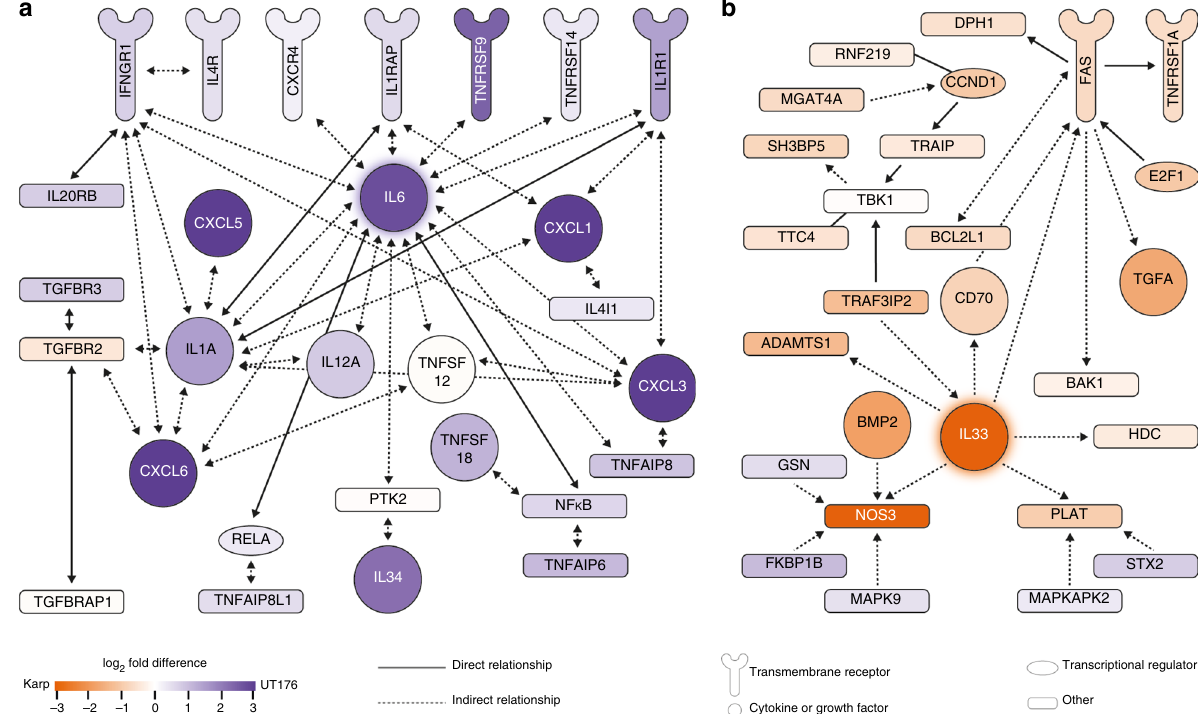
Fig. 6 Karp and UT176 lead to the upregulation of distinct networks in HUVECs. a Upregulation of multiple proin fl ammatory chemokines and cytokines in HUVECs infected with UT176. b Induction of the IL33-FAS-mediated anoikis network in Karp-infected